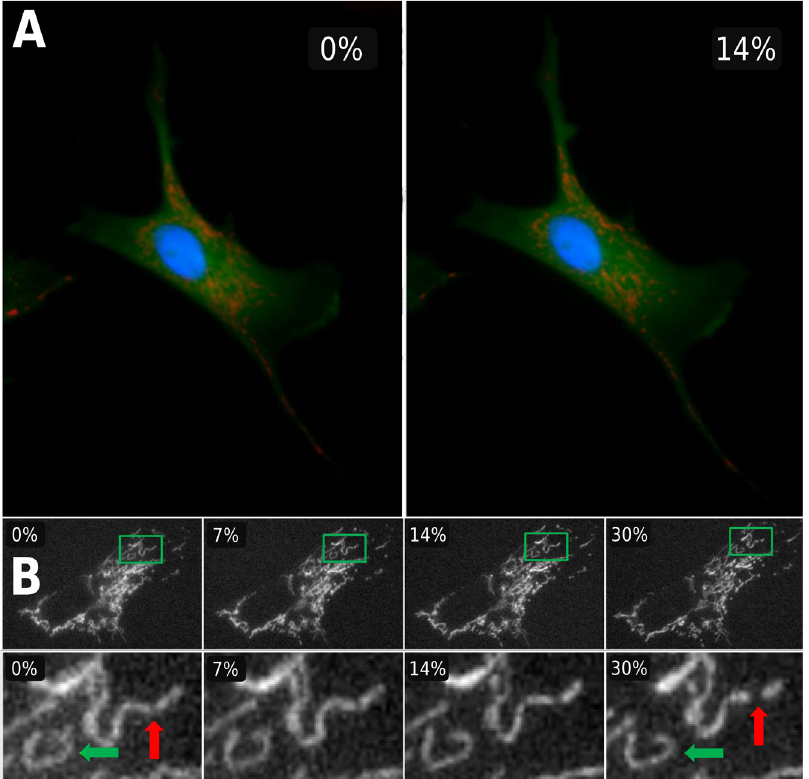
Fig 5. (A) A cell labeled for cytosol (green), mitochondria (red) and nucleus (blue) at 0% (left) and 14% (right) membrane area strains. (B)The top row shows the mitochondrial network of an entire cell imaged during constant strain application at increments of 0, 10, 20 and 40% change in membrane surface area. The bottom row shows a detail of an individual cluster (the green rectangle in top row) changing shape as higher strains are applied (green arrow), as well as a cluster undergoing fission and splitting into two smaller clusters (red